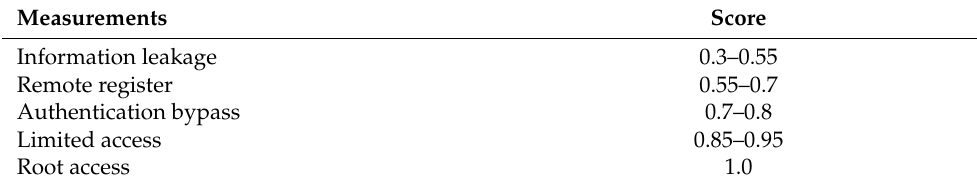
Table 5. Attack benefit index score used by Luo et al.